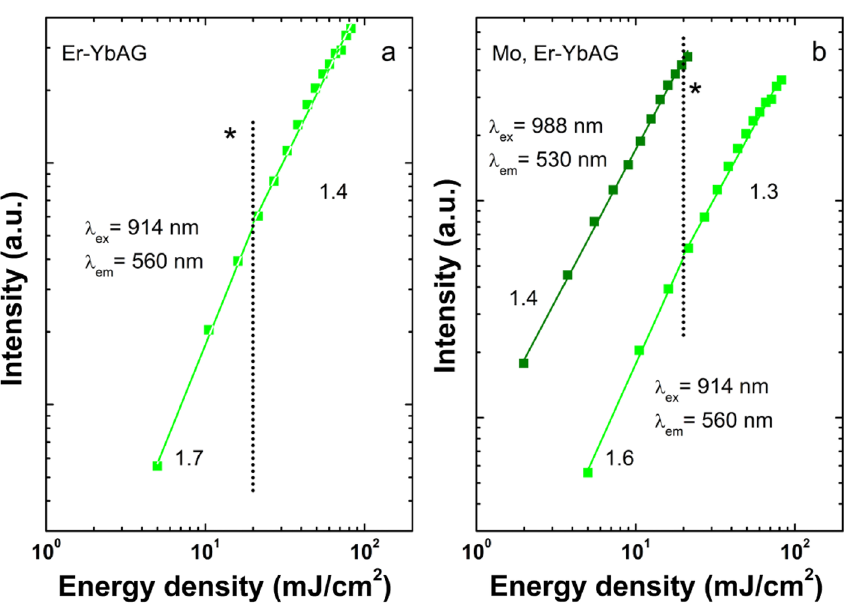
Figure 4. Energy density dependencies of Er green upconversion emission in Er-YbAG ( a ) and Mo, Er-YbAG ( b ) were monitored at 560 and 530 nm under 914 and 988 nm excitation, respectively. The vertical dotted line denoted the energy density of 20 mJ/cm 2 used in the